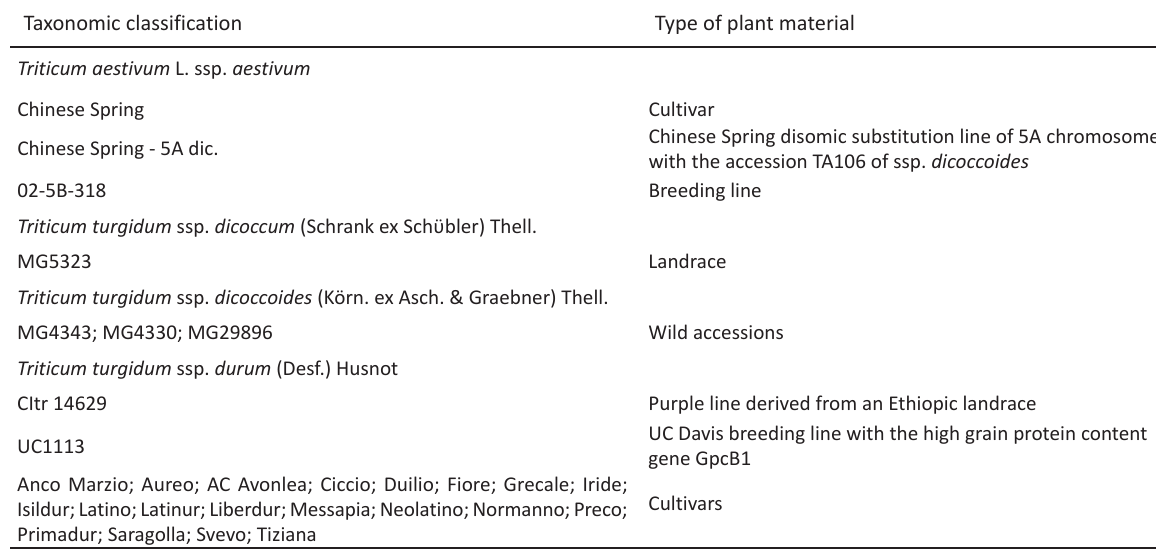
Table 1. Taxonomic classification of the wheat cultivars and accessions considered Taxonomic